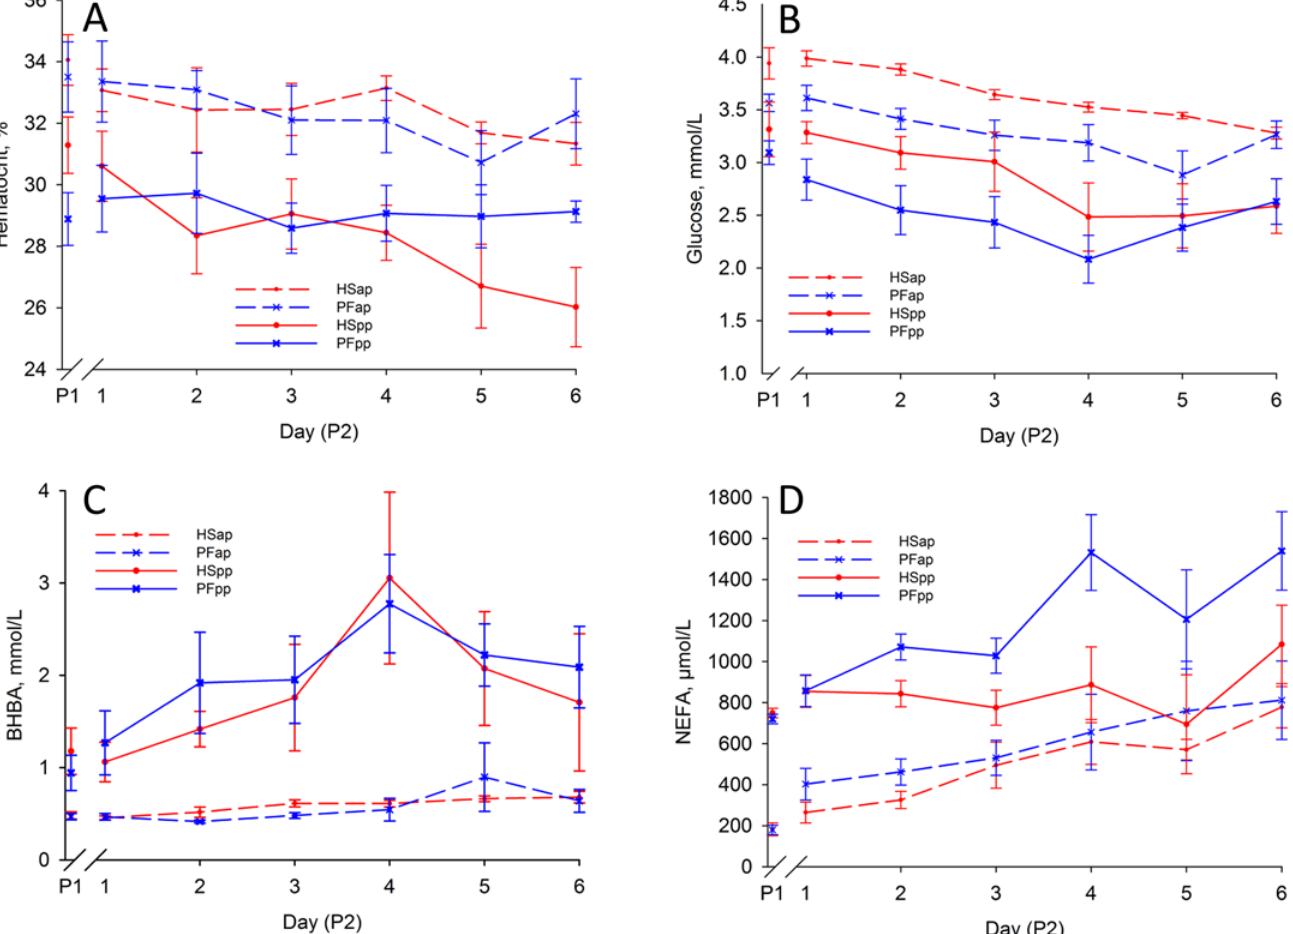
Fig 2. Hematocrit and Plasma Metabolites. Effect of heat stress (HS) and pair-feeding (PF) on (A) hematocrit, (B) plasma glucose, (C) plasma β - hydroxybutyric acid (BHBA), (D) plasma non-esterified fatty acids. In experimental period 1 (P1) all animals were kept at thermoneutral conditions (THI = 59.7) with ad-libitum feeding for six days. During period 2 (P2), HS cows (red lines) were heat-stressed (THI = 76.1), whereas PF cows (blue lines) were pair-fed in thermoneutrality (THI = 60.0) for six days, once ante partum (ap, dashed lines) and again post-partum (pp, solid lines). All data given as mean ± SEM; for P1 the mean of the last days of period 1 is given as used for baseline correction. BHBA: β -hydroxybutyric acid; NEFA: non-esterified fatty acids. Numbers of animals analyzed per group: HSap n = 7, PFap n = 6, HSpp n = 6, PFpp n =